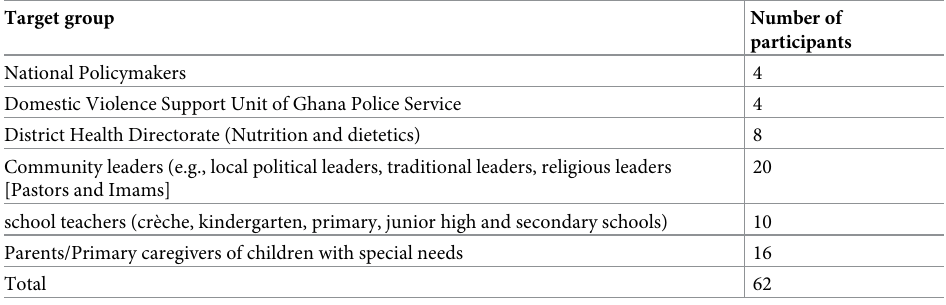
Table 1. Number of